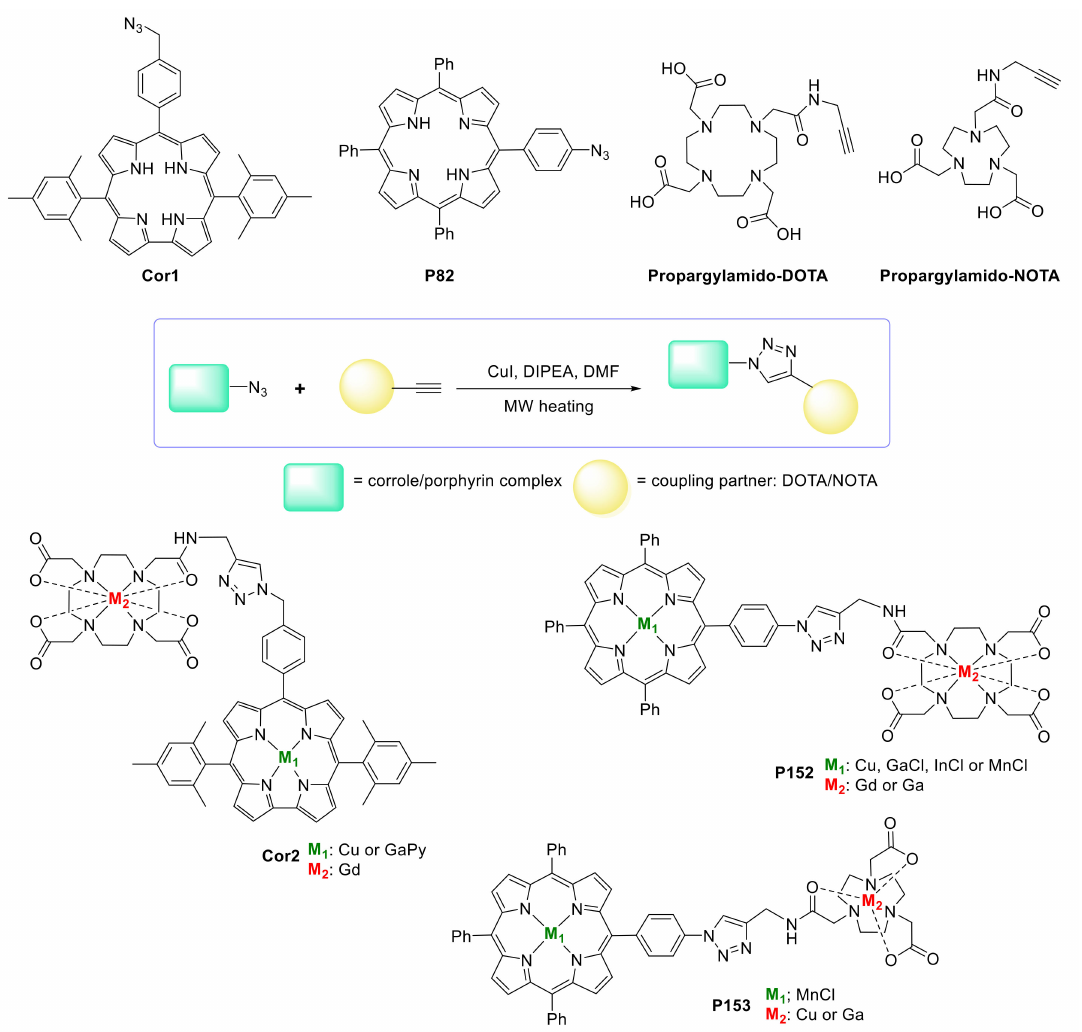
Figure 16. Structure of the heterobimetallic complexes Cor2 , P152 and P153 , and of the free-base precursors used in their